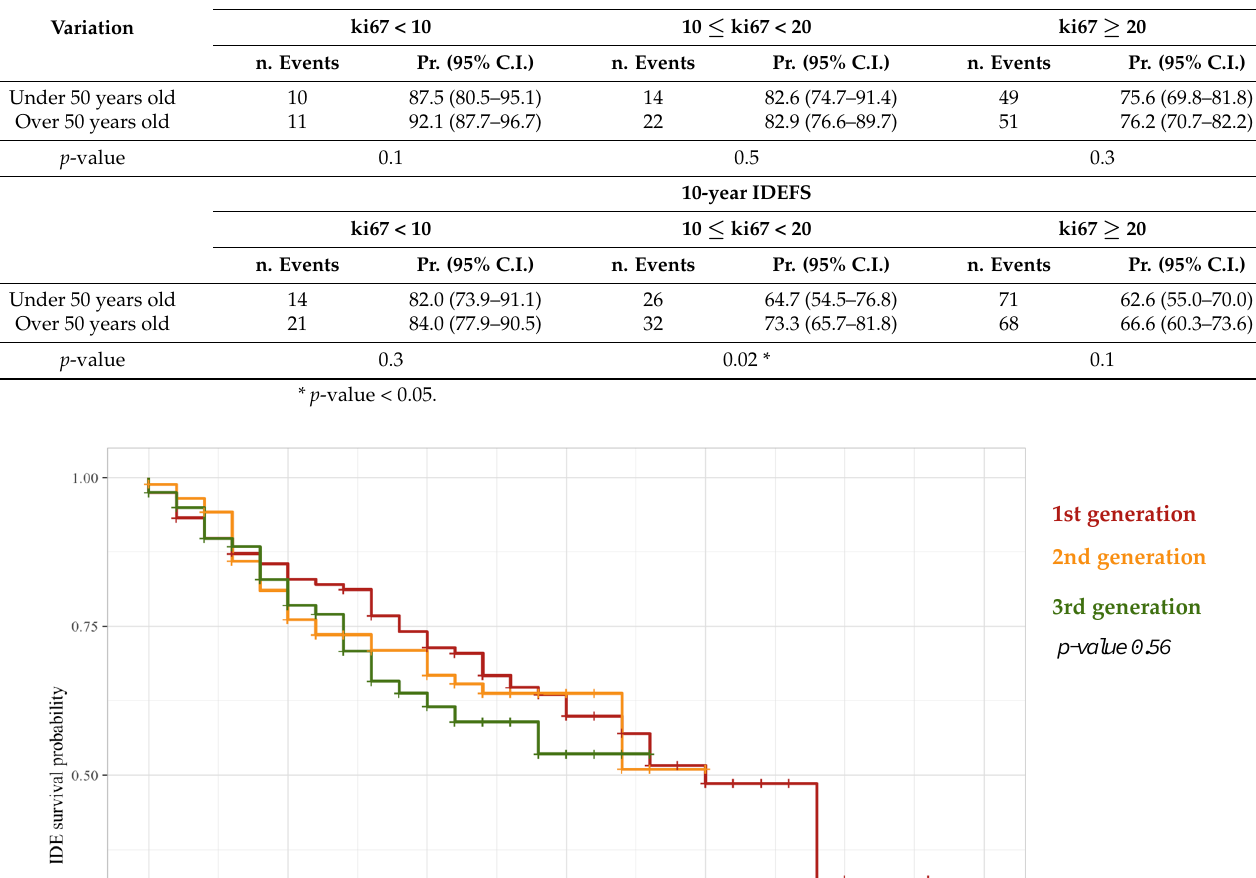
Figure 4. Multivariate analysis performed on patients under 50 years old ( a ) and over 50 years old ( b ) by means of the Cox proportional-hazard model. For each involved variable, the hazard rates (third column) and the p -values (last column) were computed by the model with respect to a specific reference value. * p -value < 0.05, ** p -value < 0.01, *** p -value < 0.001.